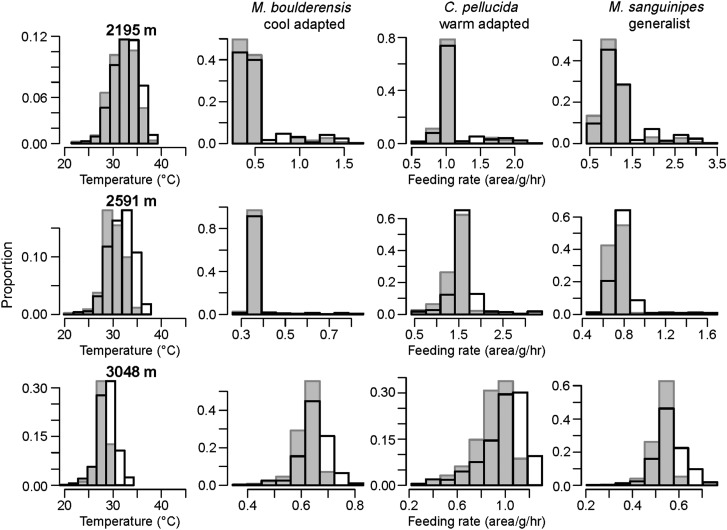
Histrogram depictions of estimated feeding performance shifts corresponding to the changes in daily mean temperature (left panels) at sites along the elevation gradient. We compare 1955–1965 (grey bars) with 2000–2010 (open bars). Estimated shifts in feeding rates (area g−1 h−1) are depicted for the three species. Values are averaged across days over daylight hours between 15 June and 15 August.